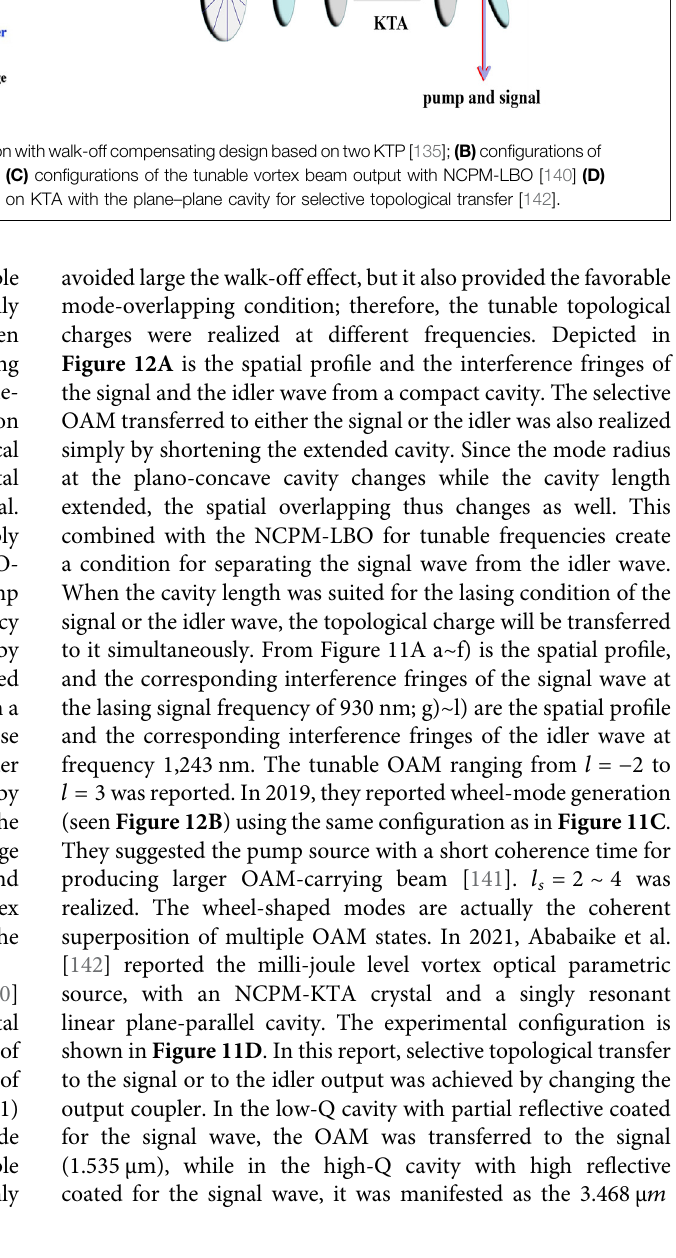
Frontiers in Physics |